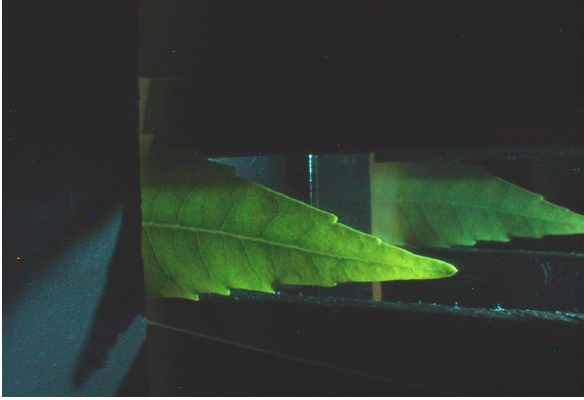
Figure 3. Image in RGB format.